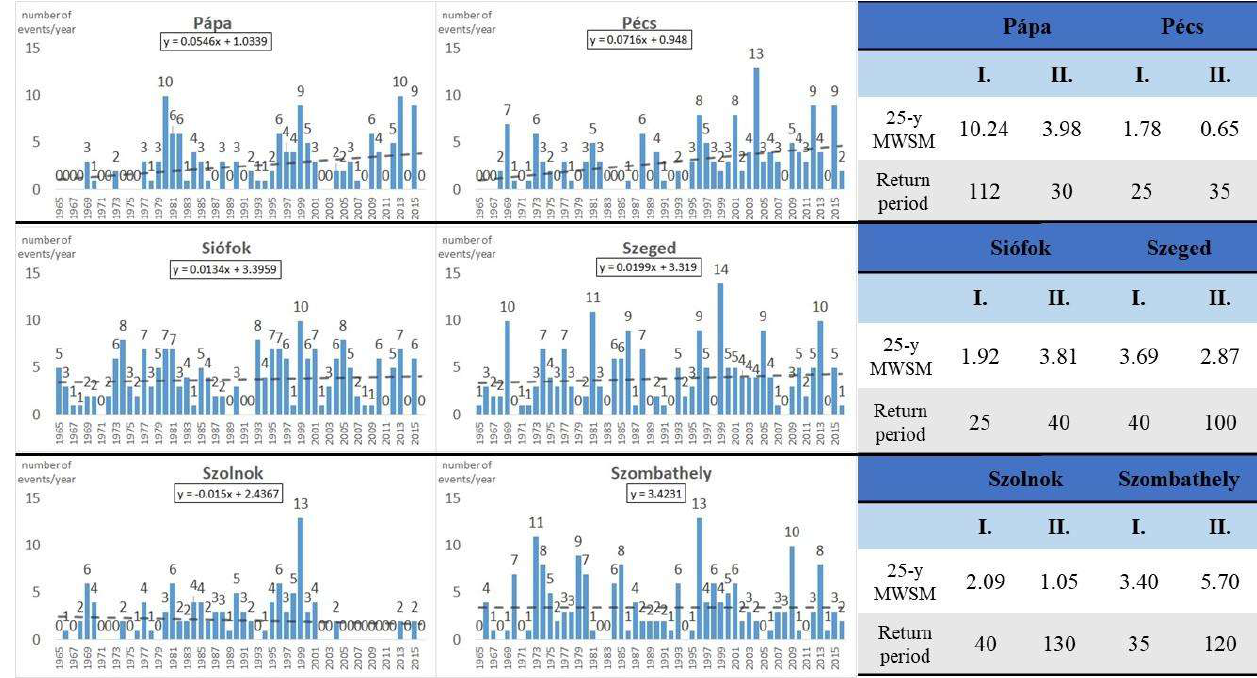
Figure 7. Annual Number of Cases (ANC) of wet snow events between 1965–2016 with a linear trend line (dotted line) and its equation ( left ) and the 25-year Maximum Wet Snow Mass (MWSM) (kg·m −1 ) and its Return period in the 1965–1990 period (Column I.) and in the 1991–2016 period